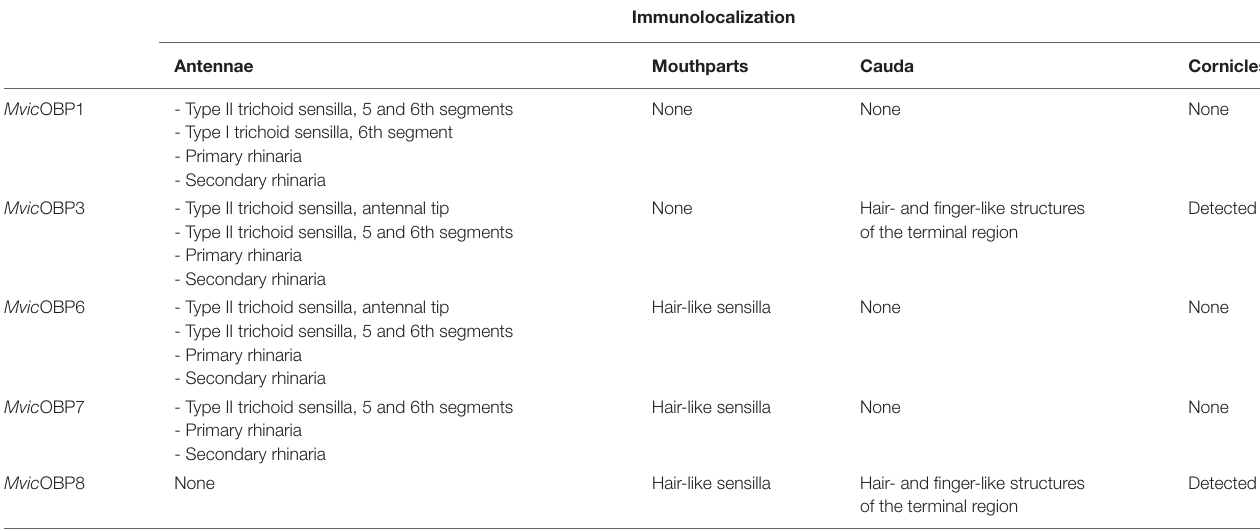
TABLE 3 | Immunolocalization of five among the ten identified MvicOBPs in different body